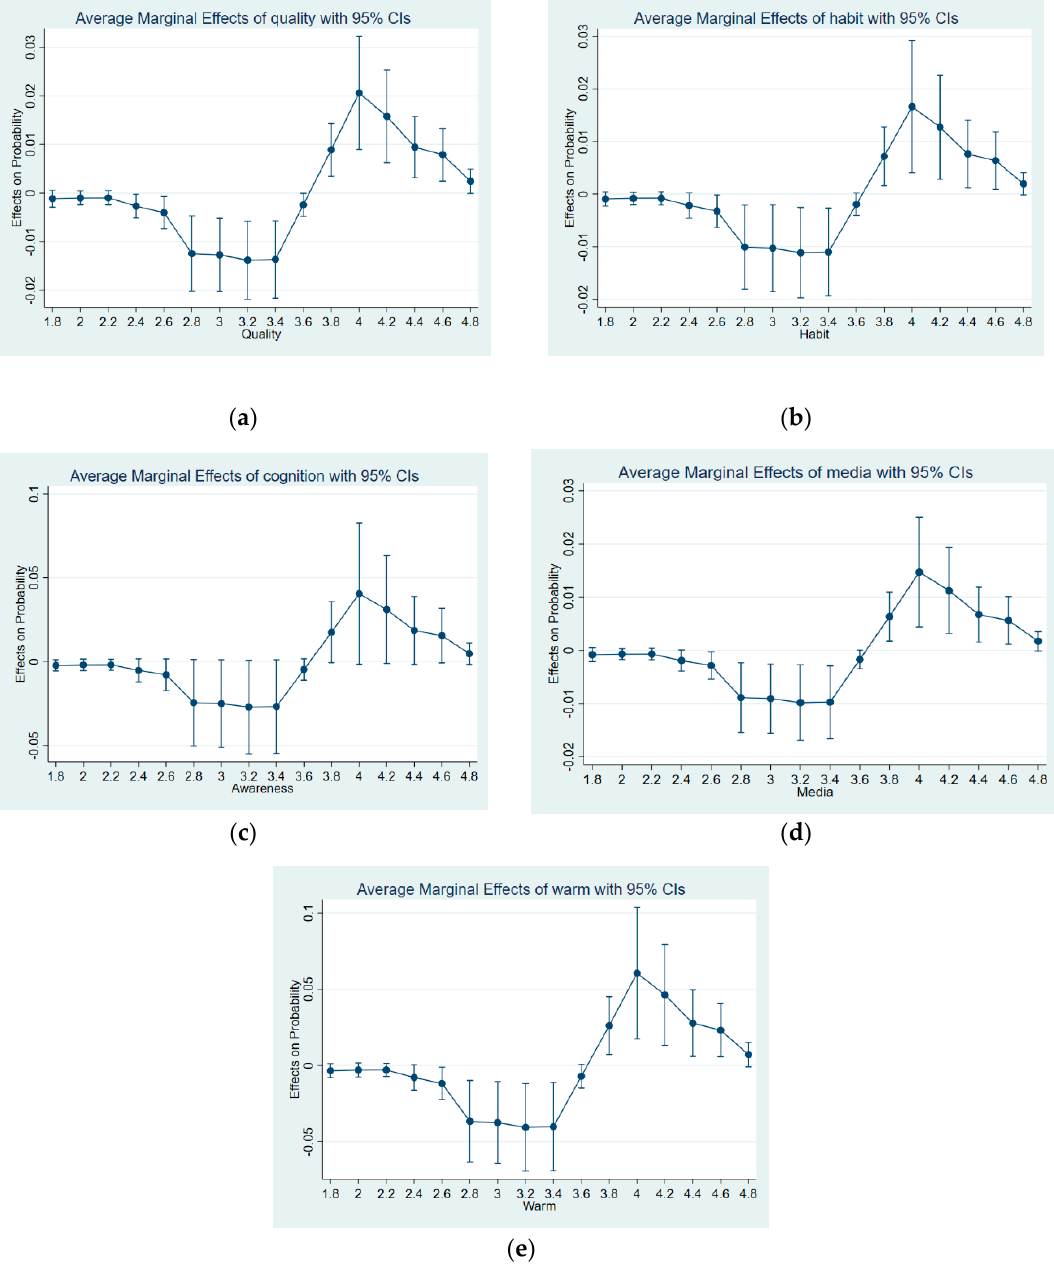
Figure 2. Marginal e ff ects of the five explanatory variables. ( a ) Average marginal e ff ects of quality; ( b ) average marginal e ff ects of habit; ( c ) average marginal e ff ects of awareness; ( d ) average marginal e ff ects of media; ( e ) average marginal e ff ects of warm.